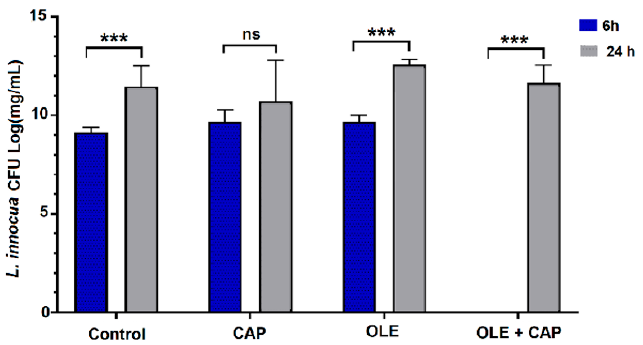
Figure 4. The effects of CAP (1 min exposure time) and/or OLE on L. innocua . The values are reported as mean ± standard error of the mean (SEM) (n = 3), significance at p < 0.05 by One-way ANOVA and Tukey’s HSD post hoc test; *** p < 0.0001, n.s. not significant.